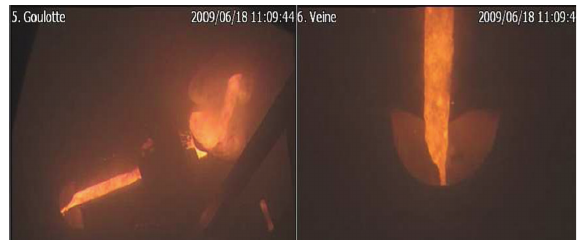
Figure 2: Pictures of VULCANO VB-ES-U2 test during corium pouring phase. Left: Corium pouring from the plasma arc rotating furnace (upper right) to the concrete cavity (lower left). Right: Zoom on the concrete hemicylindrical